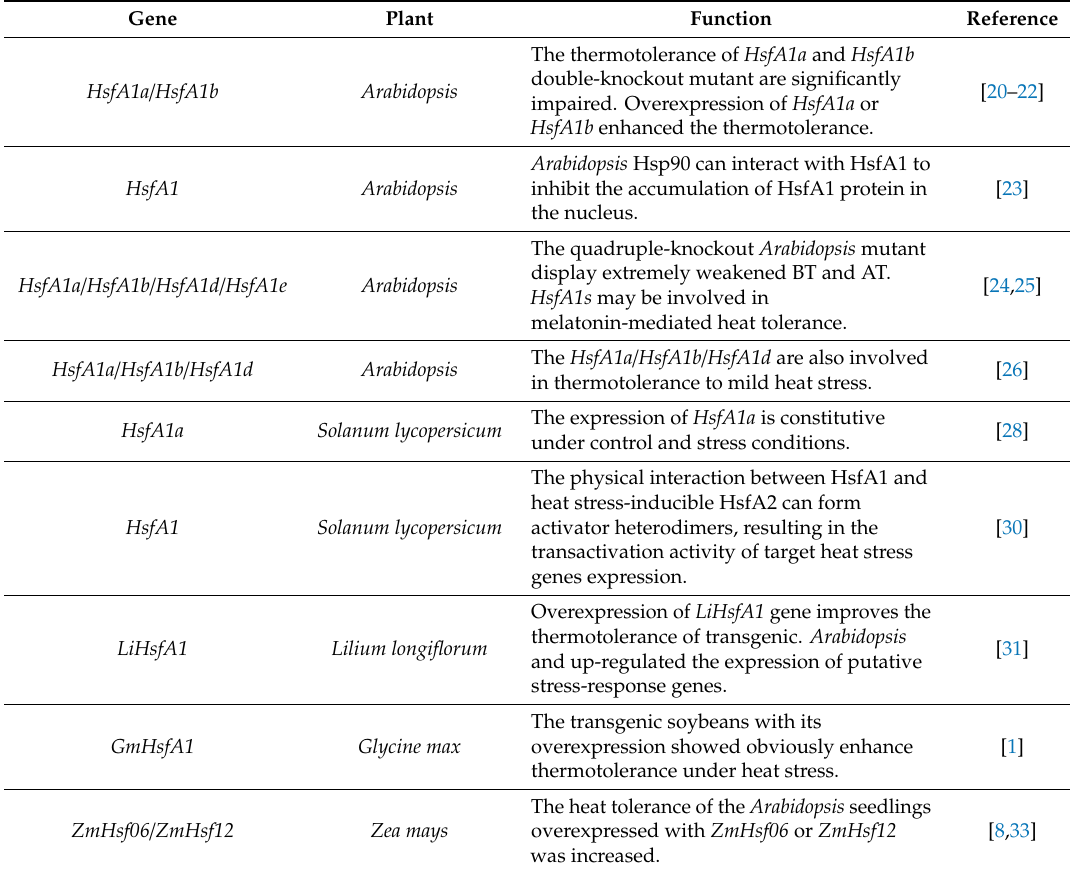
Table 1. Summary of plant HsfA1 involved in